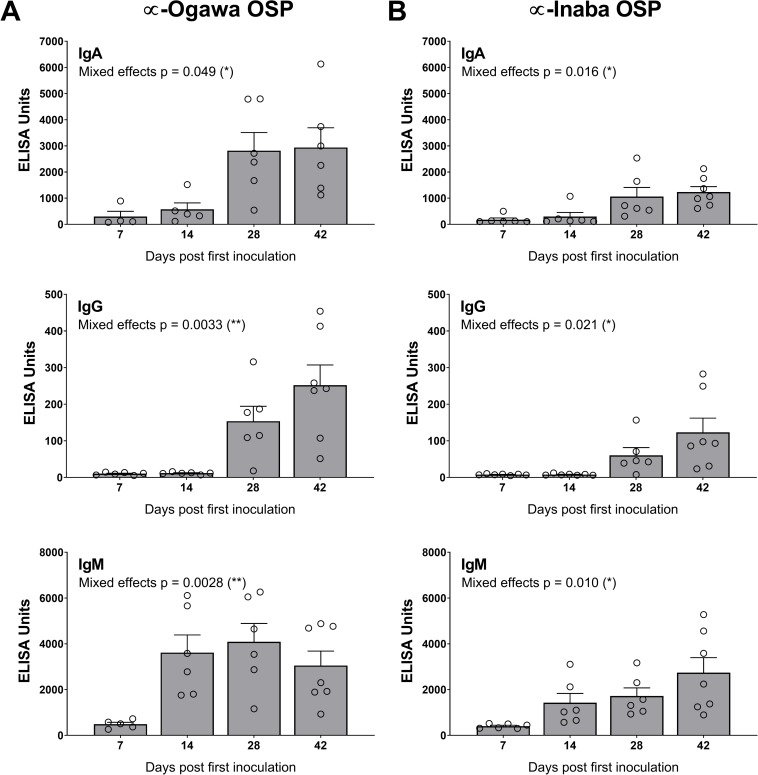
Ogawa- and Inaba-specific anti-OSP titers in C57BL/6 mice immunized with HaitiV.(A) Anti-Ogawa OSP titers with specific isotype data for IgA (top), IgG (middle) and IgM (bottom). (B) Anti-Ogawa OSP titers with specific isotype data for IgA (top), IgG (middle) and IgM (bottom). The mean ± SEM is indicated. Mixed-effect p-values were determined by one-way ANOVA analysis. Multiple comparison p-values for this data are reported in S1 Table. Although there were 7 mice per group, some samples were of insufficient volume for analysis.